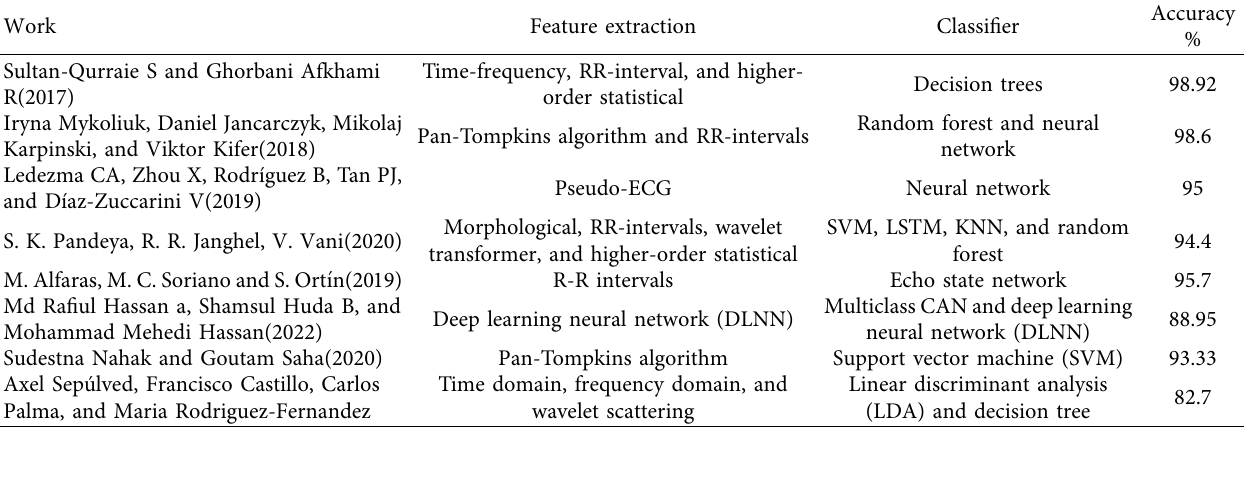
Table 1: Different classifiers have been proposed for arrhythmia discrimination.